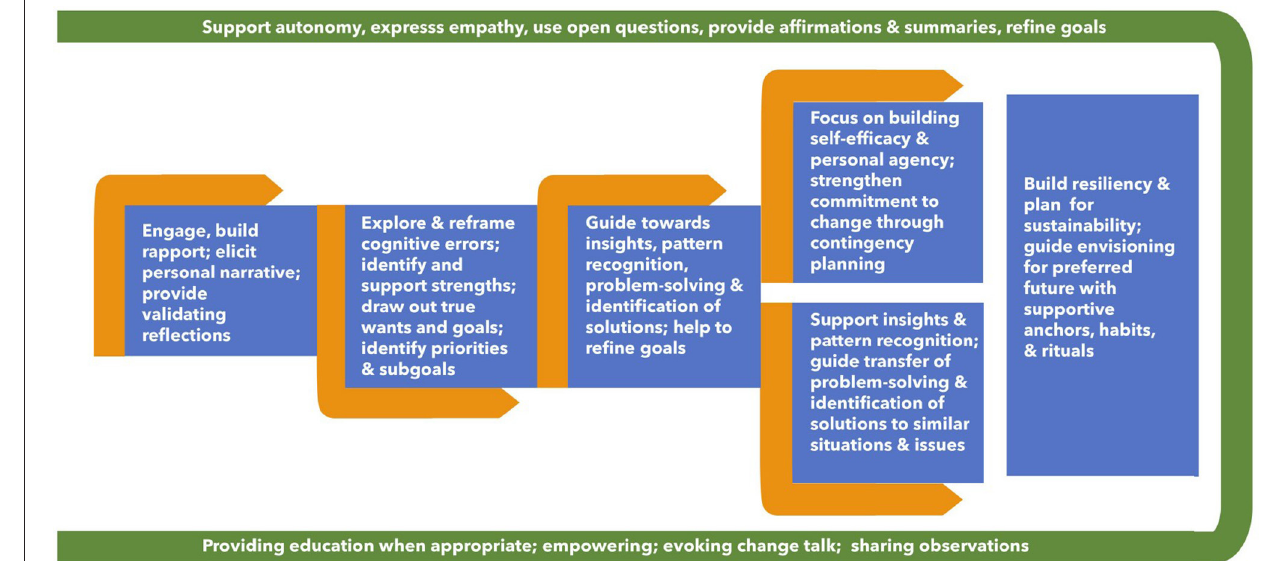
FIGURE 1 | Process flow of health coaching weeks one through